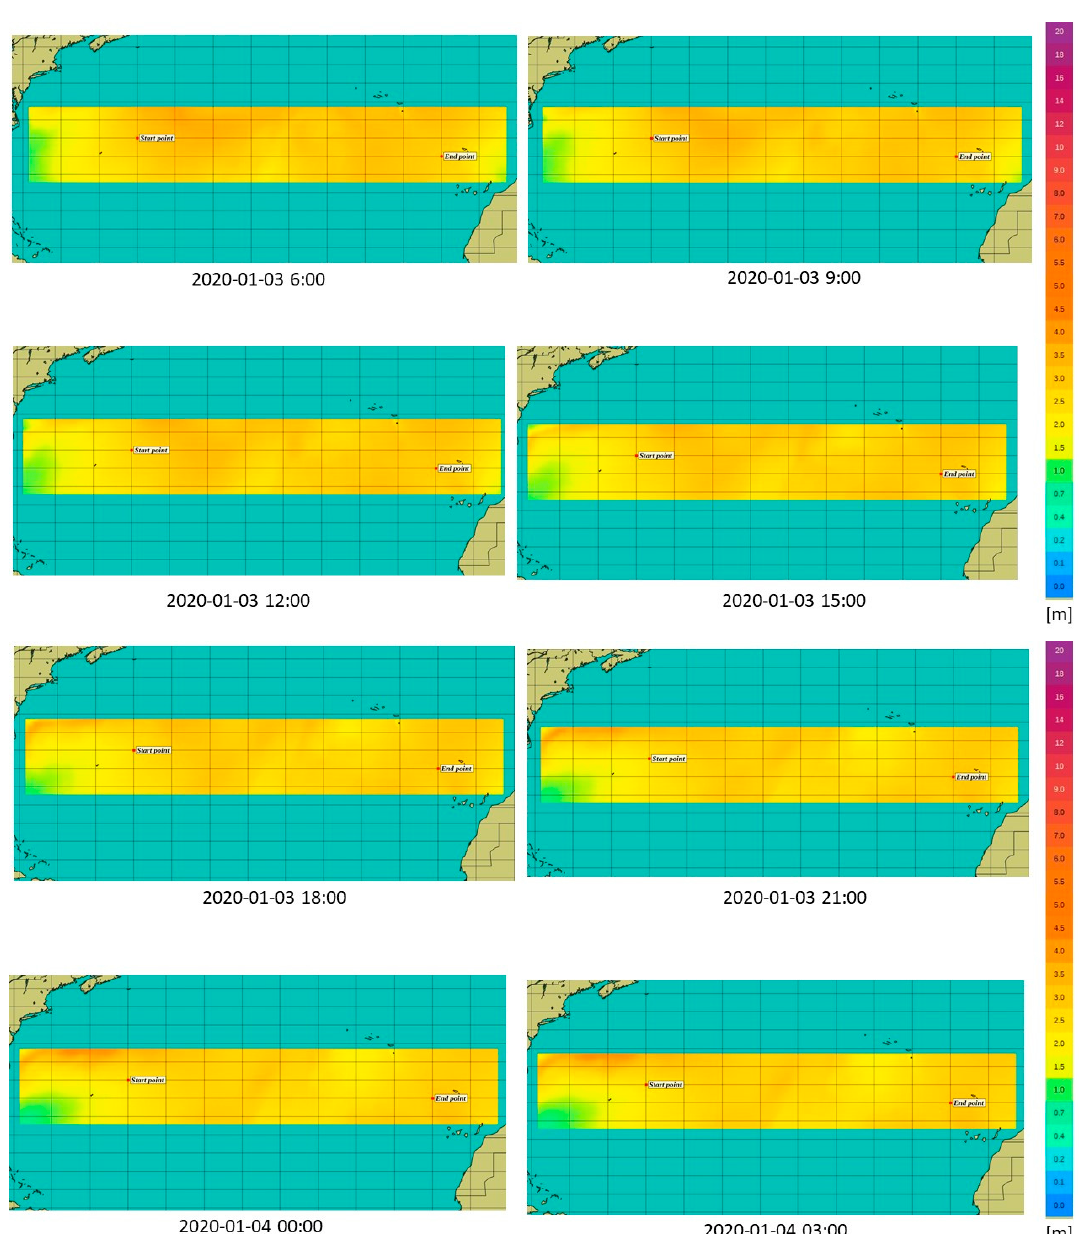
Figure 3. Time trend of the significant wave height from 06:00 UTC on 3 January 2020 up to 03:00